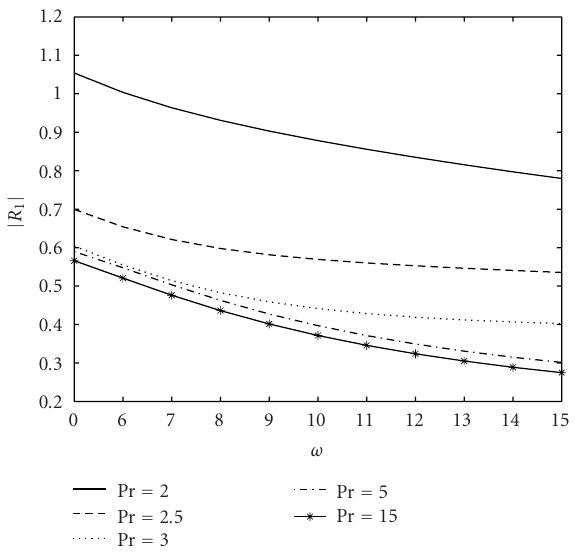
Figure 4.5. Amplitude of the shear stress due to main flow for Gr = 5 . 0, S = 1 . 0, z = 0 . 2.